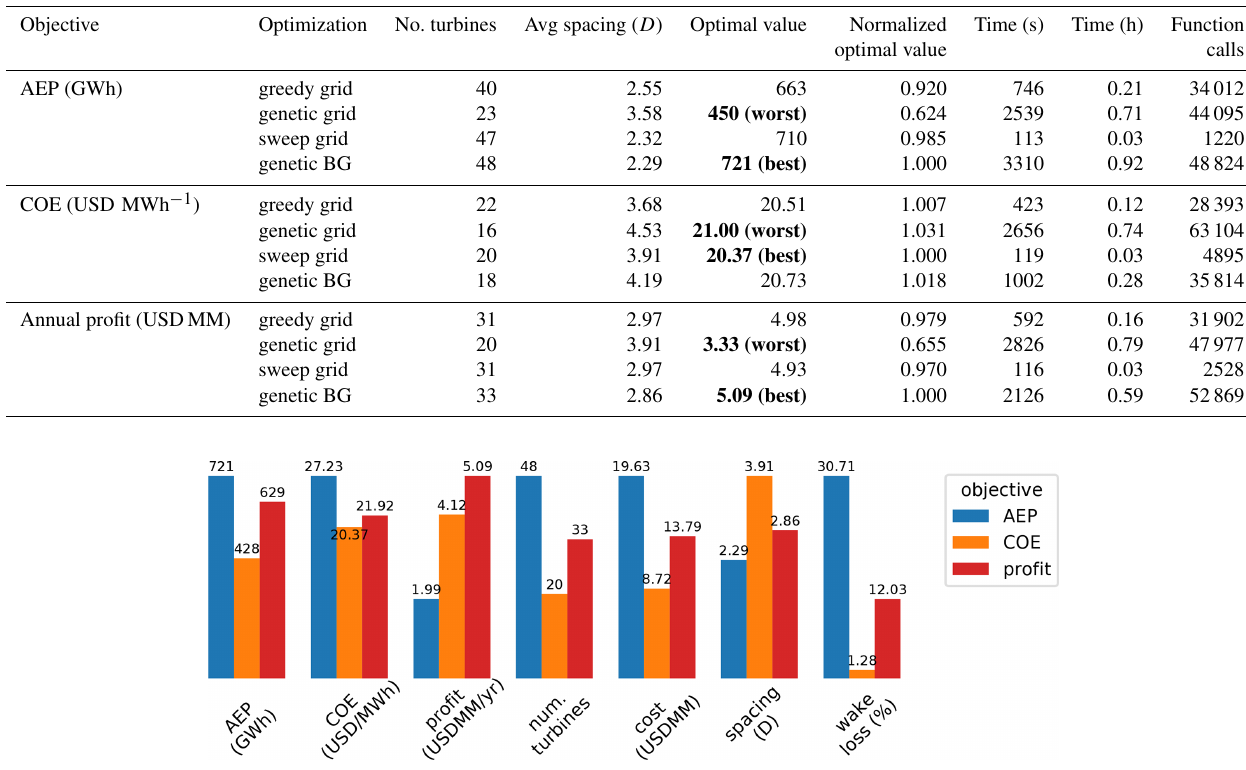
Figure 10. A comparison of the performance metrics of the three different wind power plants optimized for different objective functions. These results are shown for the large wind plant with a unidirectional wind